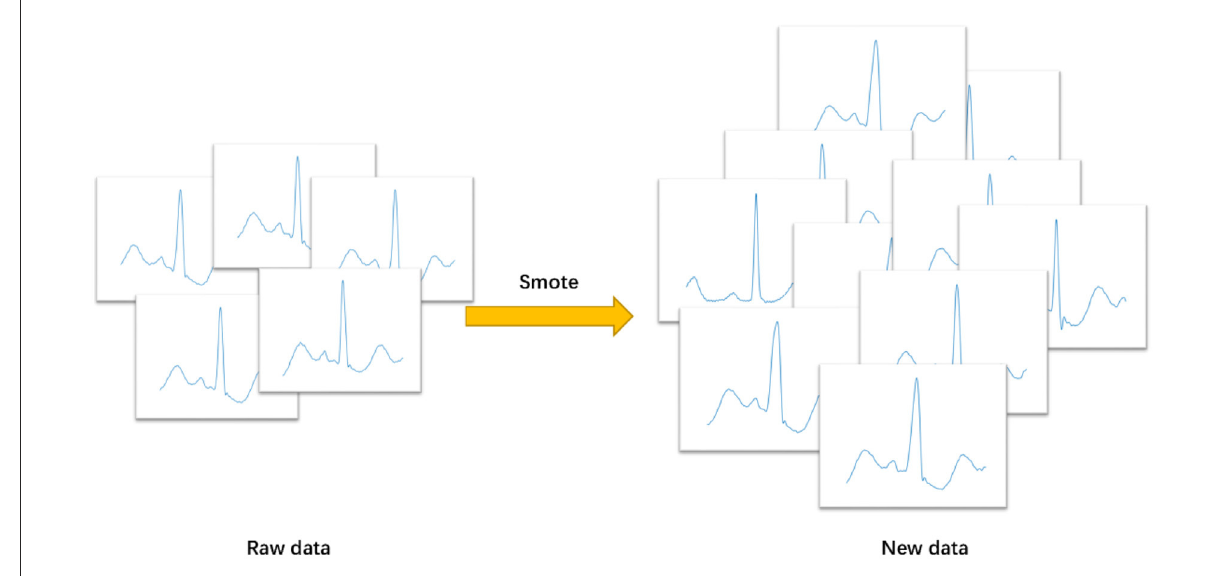
FIGURE4 Smote result of class F samples.